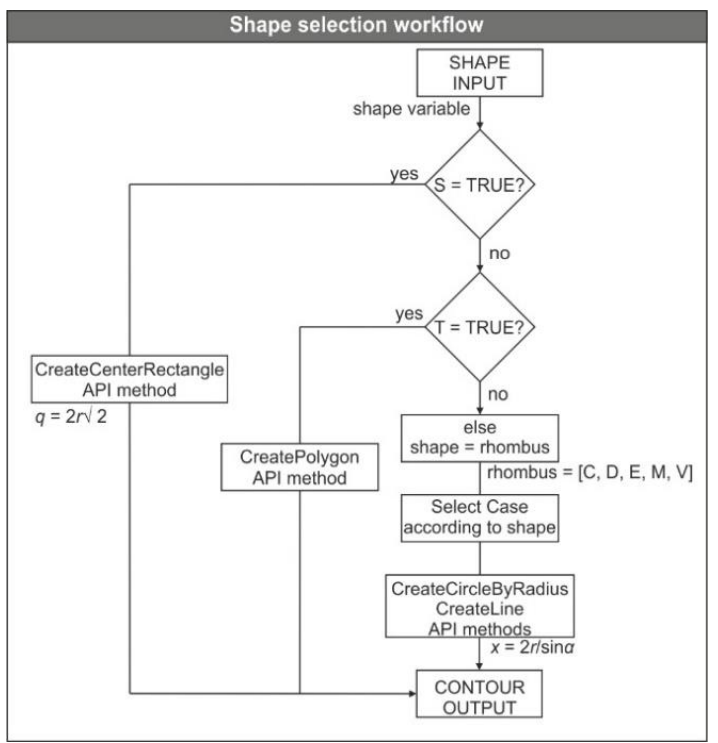
Figure 6. The shape selector algorithm flowchart.